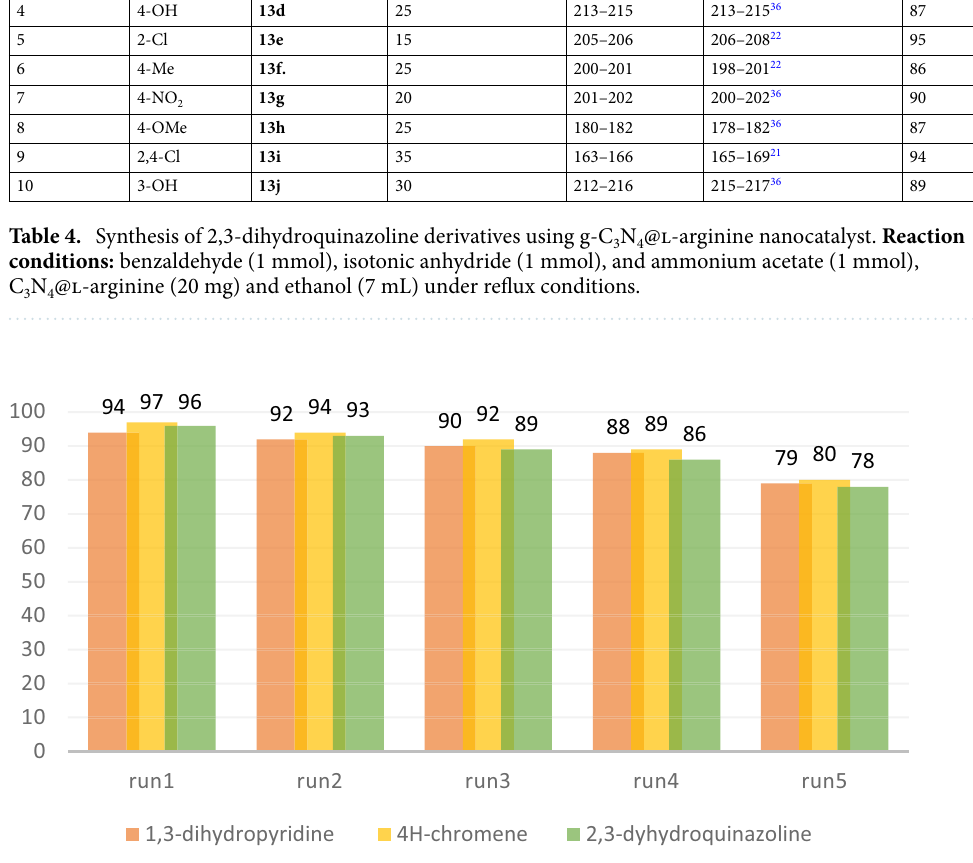
Figure 8. Examination of g-C 3 N 4 @l-arginine reusability in synthesis of 1, 3-dihydropyridine 5b, 4 H -chromene 9b , and 2, 3-dihydroquinazoline 13b